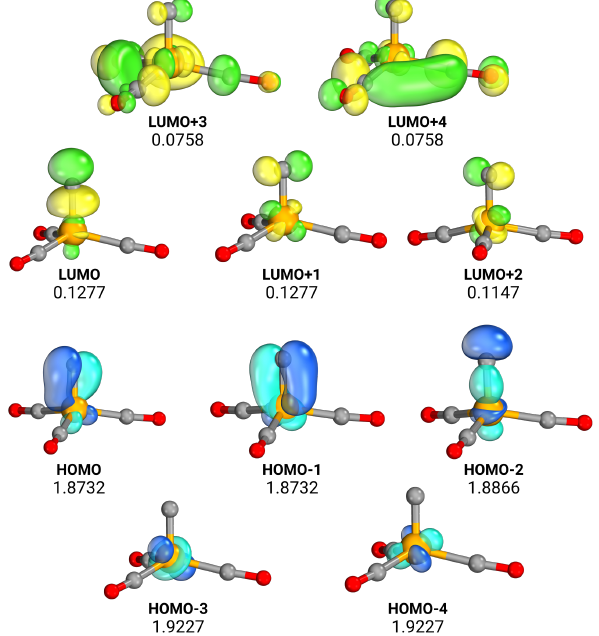
Figure 1. The (10,10) initial active space as obtained from the UNO procedure. Below the labels, the fractional occupations of the converged CASSCF natural orbitals. Carbon atoms are shown in grey, oxygens in red, and the iron atom in orange. Orbitals are visualized with the IboView software